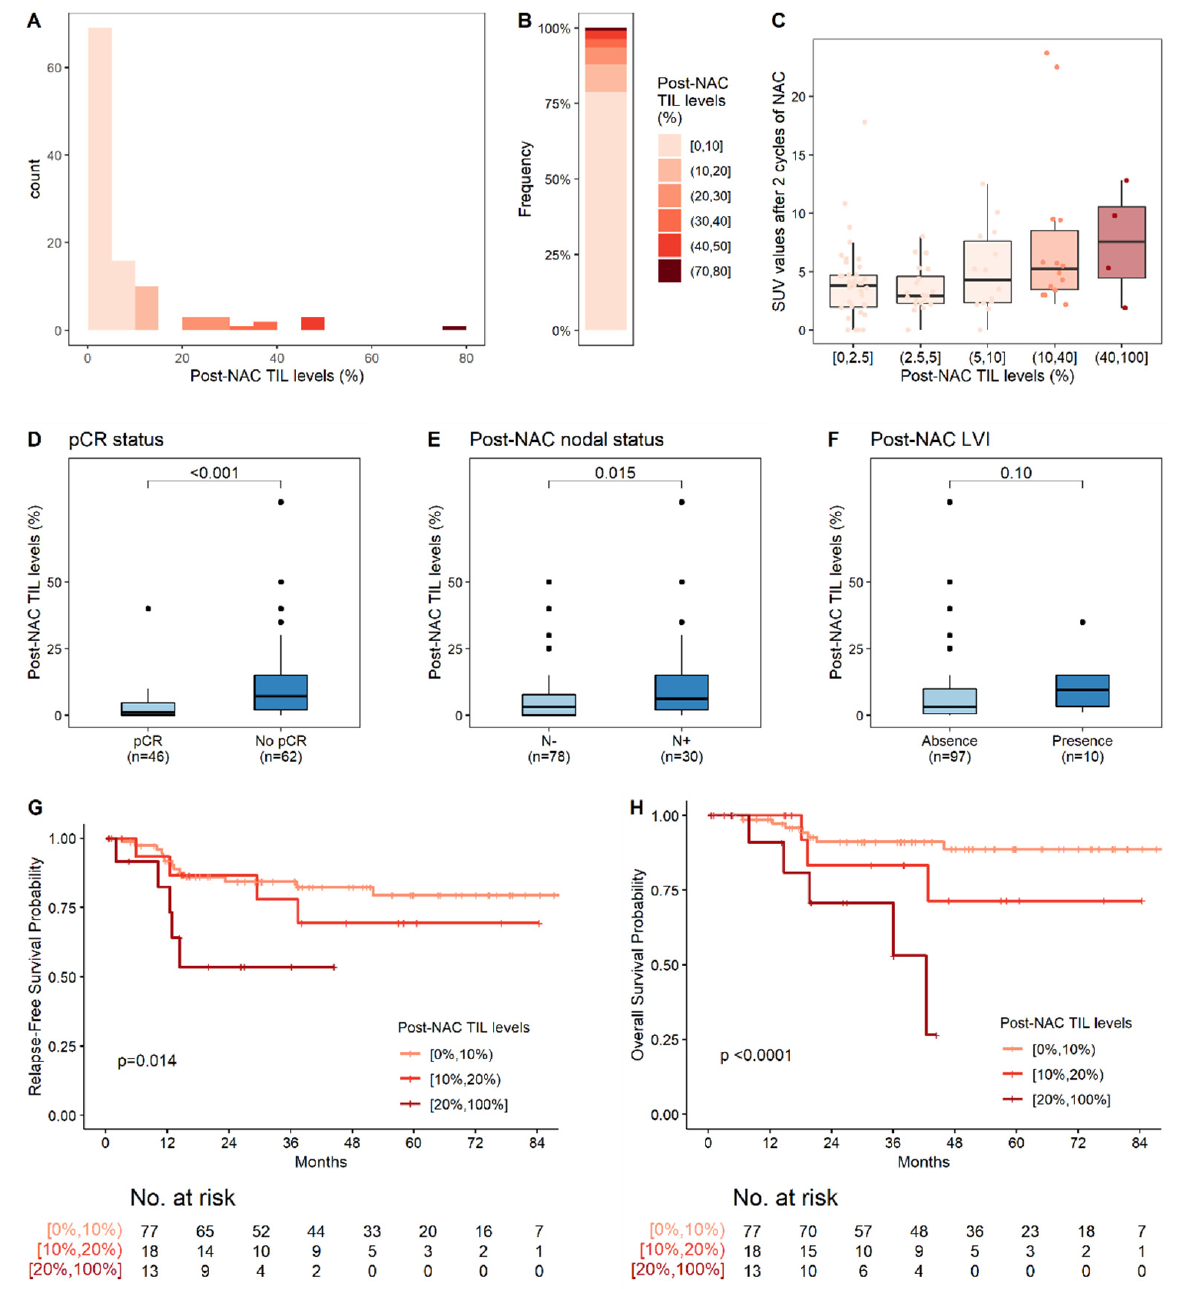
Figure 4. Post-NAC TIL levels and their association with post-NAC pathological factors. ( A ) Distribution of post-NAC TIL levels; ( B ) Distribution of post-NAC TIL levels, by increments of 10%; ( C ) Association of post-NAC TIL levels with SUV values after two cycles of NAC; ( D – F ) Association of post-NAC TIL levels with clinical and pathological factors: pCR status ( D ); post-NAC nodal involvement ( E ); and post-NAC LVI ( F ); ( G , H ) RFS ( G ) and OS ( H ) according to post-NAC TIL level, stratified into three classes: 0–10%; 10–20%; ≥ 20%. The reported p -values are those for post-NAC TIL levels in the corresponding multivariate Cox regression (i.e., the continuous TIL levels, after adjustment for post-NAC nodal involvement and post-NAC LVI for RFS ( G ) and for post-NAC LVI for OS ( H )). The corresponding Cox regressions are reported in Tables 3 and S5, respectively.